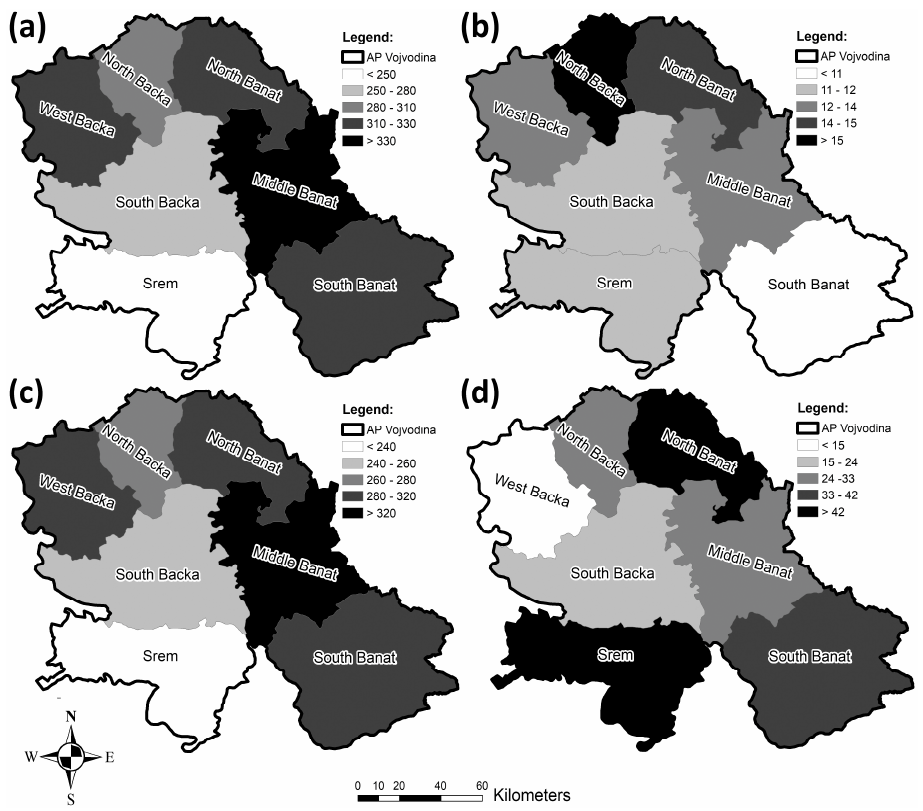
Figure 19. Geographical distribution of the diabetes incidence/mortality rates per 100,000 population in the researched area from 2010 to 2019: ( a ) incidence rates for both diabetes types, ( b ) incidence rates for type 1 diabetes, ( c ) incidence rates for type 2 diabetes, and ( d ) mortality rates for both diabetes types.